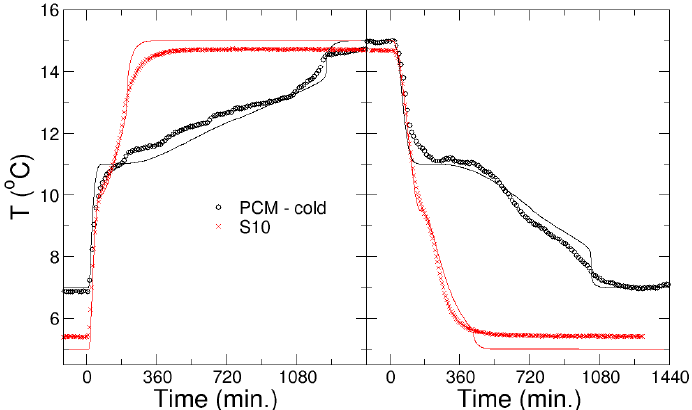
Figure 6. Kinetics of melting (left panel) and freezing (right panel) of the PCM developed within the project for the cooling application and the commercial one S10, as shown by the evolution of the temperature in the nodule center. Experiments (symbols) and simulations (lines) are shown.